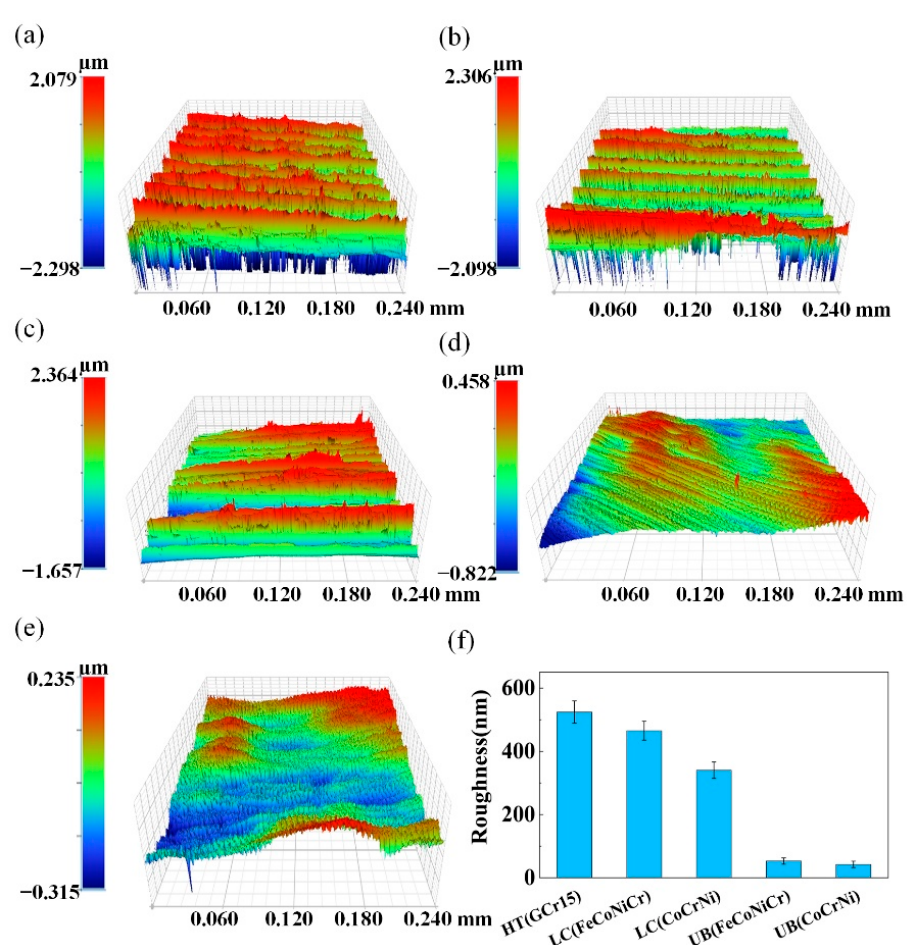
Figure 4. Three-dimensional surface roughness measurements of five samples. ( a ) HT(GCr15), ( b ) LC(FeCoNiCr), ( c ) LC(CoCrNi), ( d ) UB(FeCoNiCr), and ( e ) UB(CoCrNi). ( f ) Comparison of surface roughness parameter S a of five samples.